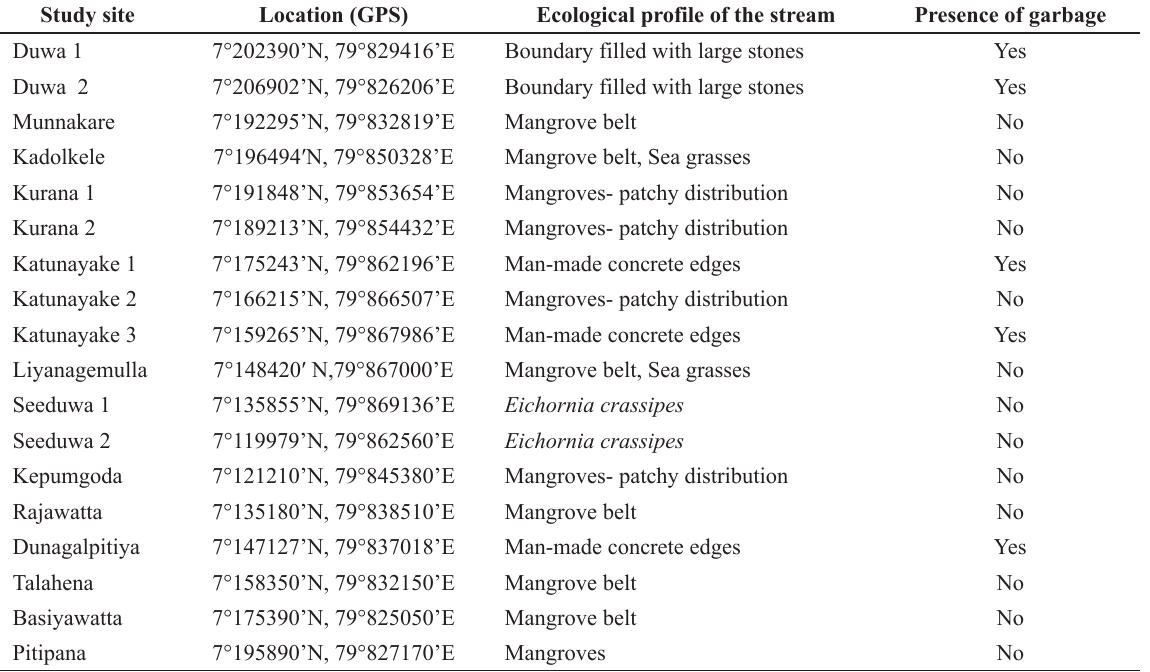
Table 1: Qualitative description of sampling sites, Negombo Lagoon. Study